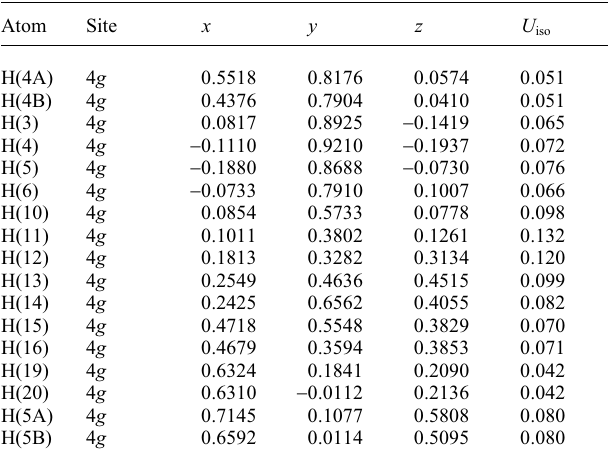
Table 2. Atomic coordinates and displacement parameters (in Å 2 )